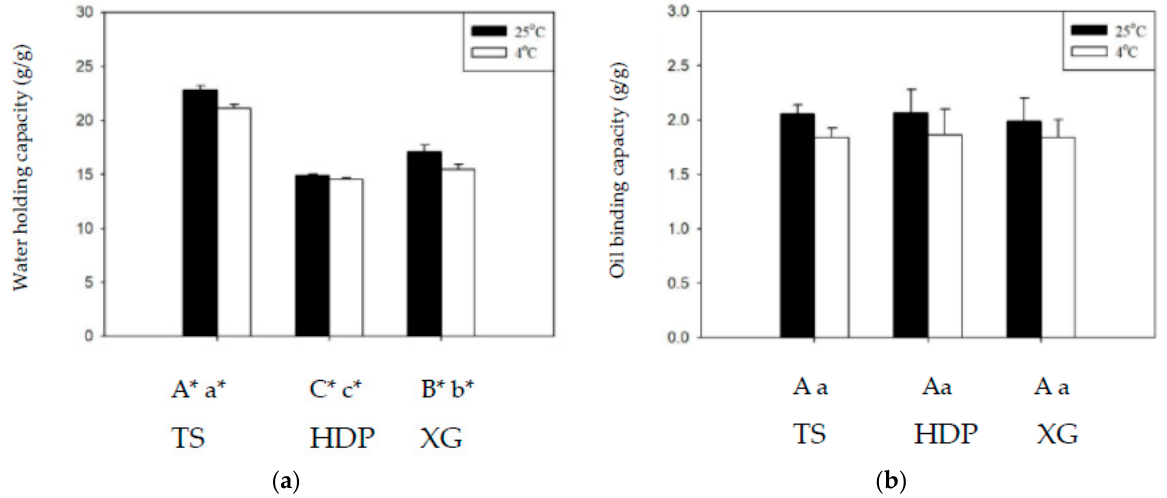
Figure 3. The water holding capacity ( a ) and oil binding capacity ( b ) at 4 and 25 ◦ C for the thickeners. TS: tapioca starch; HDP: hydroxypropyl distarch phosphate; XG: xanthan gum. Error bars represent standard deviations. The uppercase letters are significantly different ( p < 0.05) at 4 ◦ C. The lowercase letters are significantly different ( p < 0.05) at 25 ◦ C. * is significant difference ( p < 0.05) between 4 and 25 ◦